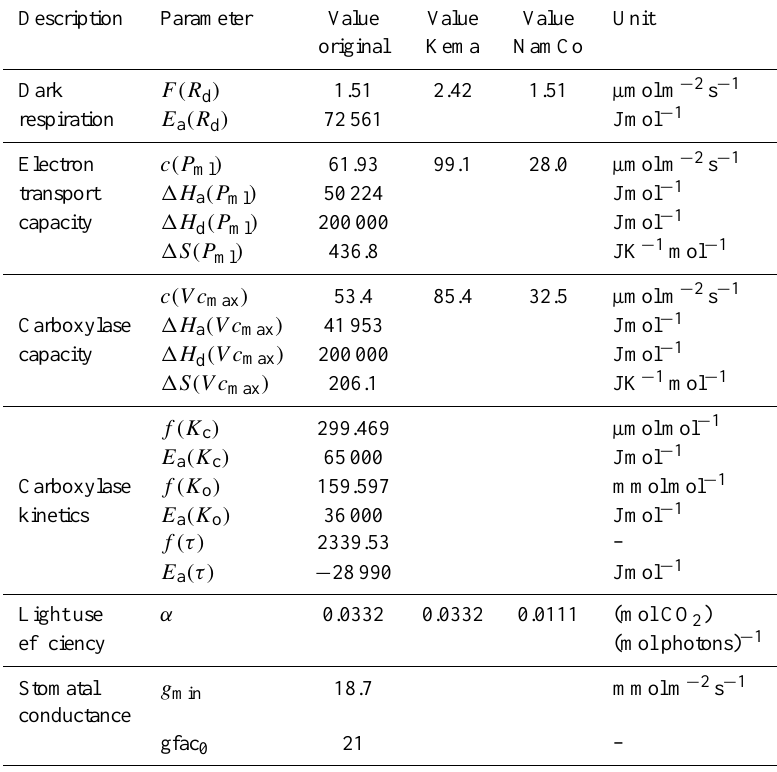
Table A2. Parameters applied to describe leaf physiology of Kobresia pygmaea . For detailed explanation of the leaf model and use of the parameters see Falge (1997) and Falge et al. (2003). The equations are also available in Wohlfahrt et al. (1998). Output of the model is on a projected leaf area